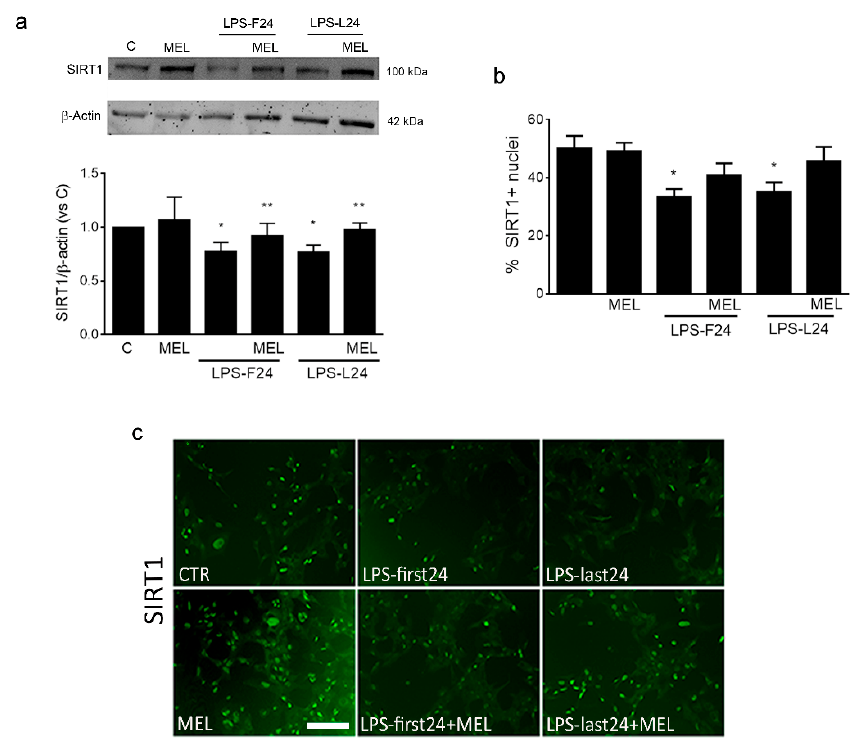
Figure 7. MEL’s effects on SIRT1 expression in HMC3 cells under inflammation. MEL (1 µ M) was always added for 48 h. When in combination with LPS (1 µ g/mL), two different settings were used: LPS was added for the first 24 h, followed by removal and further incubation for 24 h (LPS-F24); alternatively, cells were incubated for 24 h prior to addition of LPS for the last 24 h (LPS-L24). In ( a ), total SIRT1 expression was evaluated by Western blot analysis and a representative blot is shown. The percentage of cells with nuclear SIRT1 was then determined by immunolabeling, followed by cell count. Results are graphed in ( b ) and representative images of immunostaining (green) are shown in ( c ). Scale bar = 80 μ m. Data are mean ± SEM of 3 independent experiments. * p < 0.05 vs. C and ** p < 0.05 vs. corresponding LPS-treated, by one-way ANOVA followed by Fisher-LSD post hoc